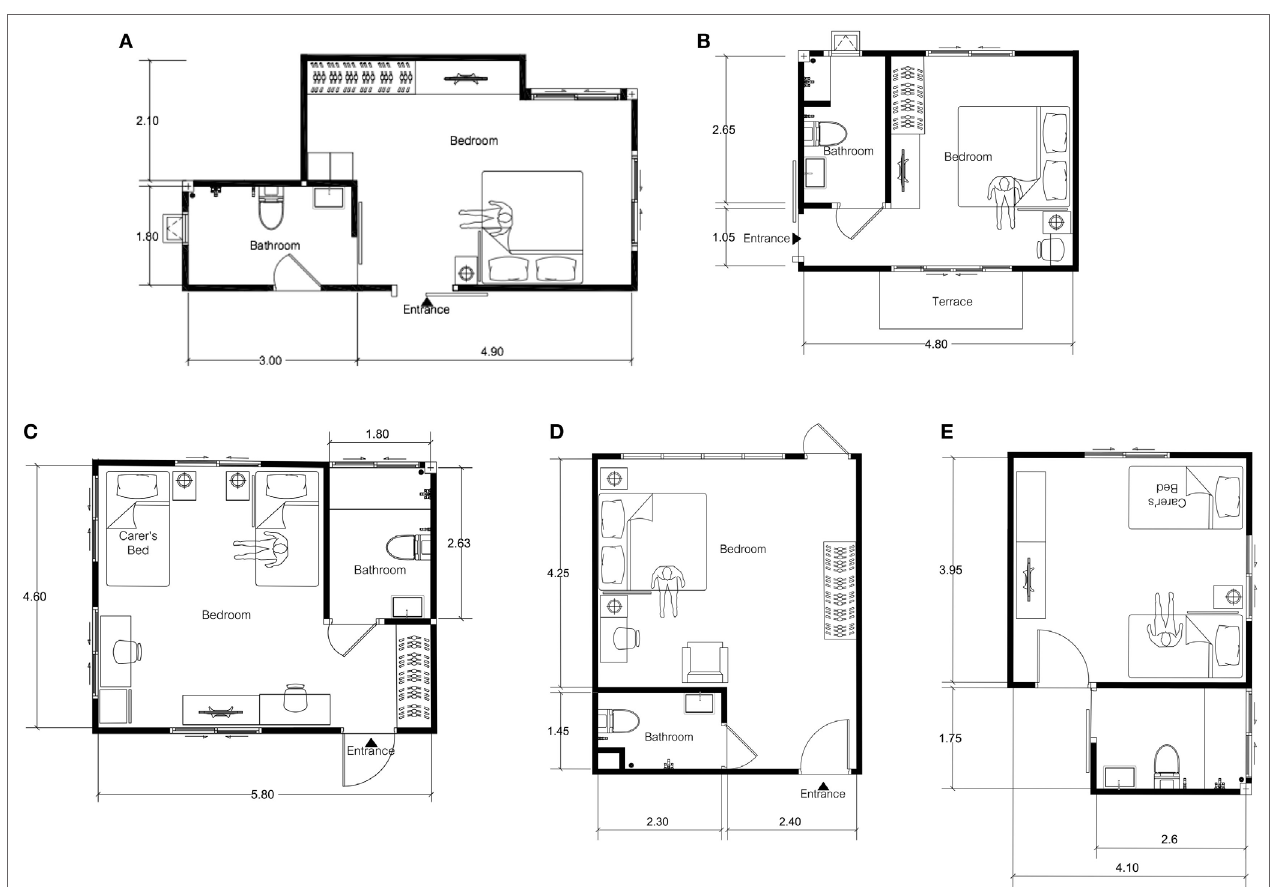
FigUre 1 | Floor plan of Parkinson’s disease patient’s bedrooms and adjacent bathrooms, labeled as (a–e) for patients 1–5